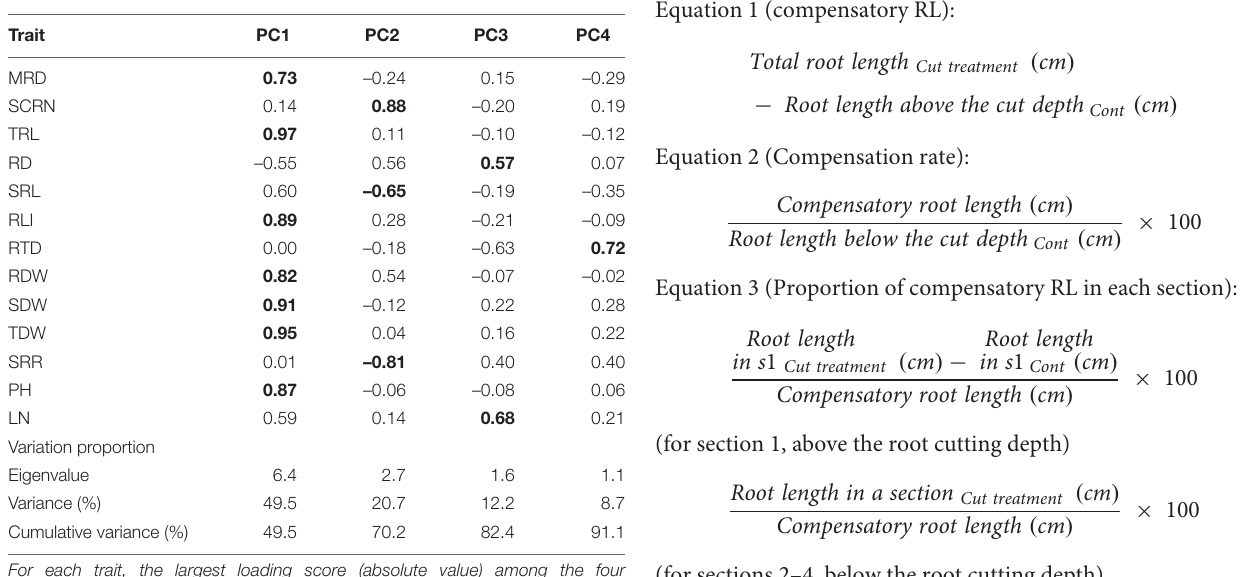
TABLE 4 | Loading scores of 13 selected traits and eigenvalues and the proportion of each principal component